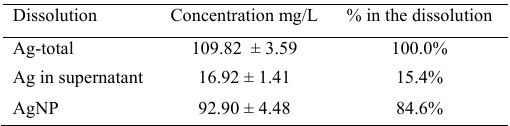
Table 4. Amount of Ag in mg/L measured by the atomic absorption technique, for the different fractions (Ag total, Ag in the supernatant and Ag NPs) for biosynthesis with Eichhornia crassipes leaves at